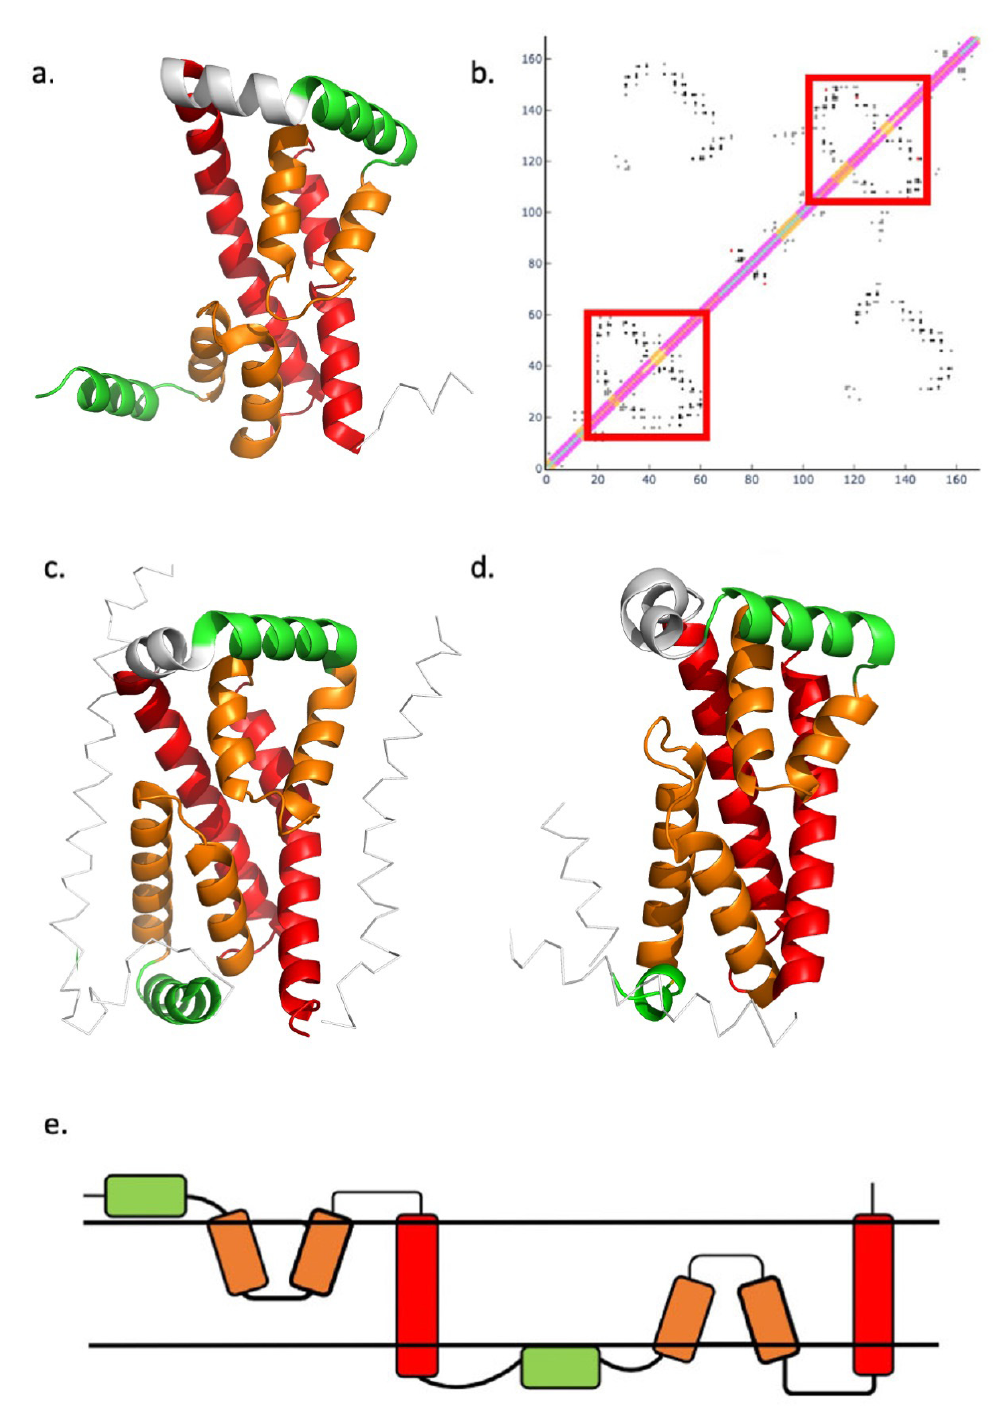
Figure 4. ( a ) trRosetta model of MT2055 - amphipathic helix (green) and a re-entrant loop (orange) packed with a TM helix (red) ( b ) Superposition of DMP predicted contact map for Mt2055 and contacts from the Mt2055 model. Black points are matching contacts, red are mismatches and grey are contacts predicted but not present in the model. Diagonal is a visual representation of transmembrane helix and secondary structure prediction – central diagonal is the visualisation of the TopCons transmembrane prediction (orange being a TM helix) and the outer diagonals are the visual representation of the PSIPRED secondary structure prediction (pink – alpha helix and yellow – coil). Red boxes highlight the re-entrant loop and TM helix packing contact map signature. c ) trRosetta model of Tmem41b only showing the conserved structural domain (residues 39-217) d ) trRosetta model of YqjA only showing the conserved structural domain (residues 14- 176). e ) Proposed topology for (extended) DedA